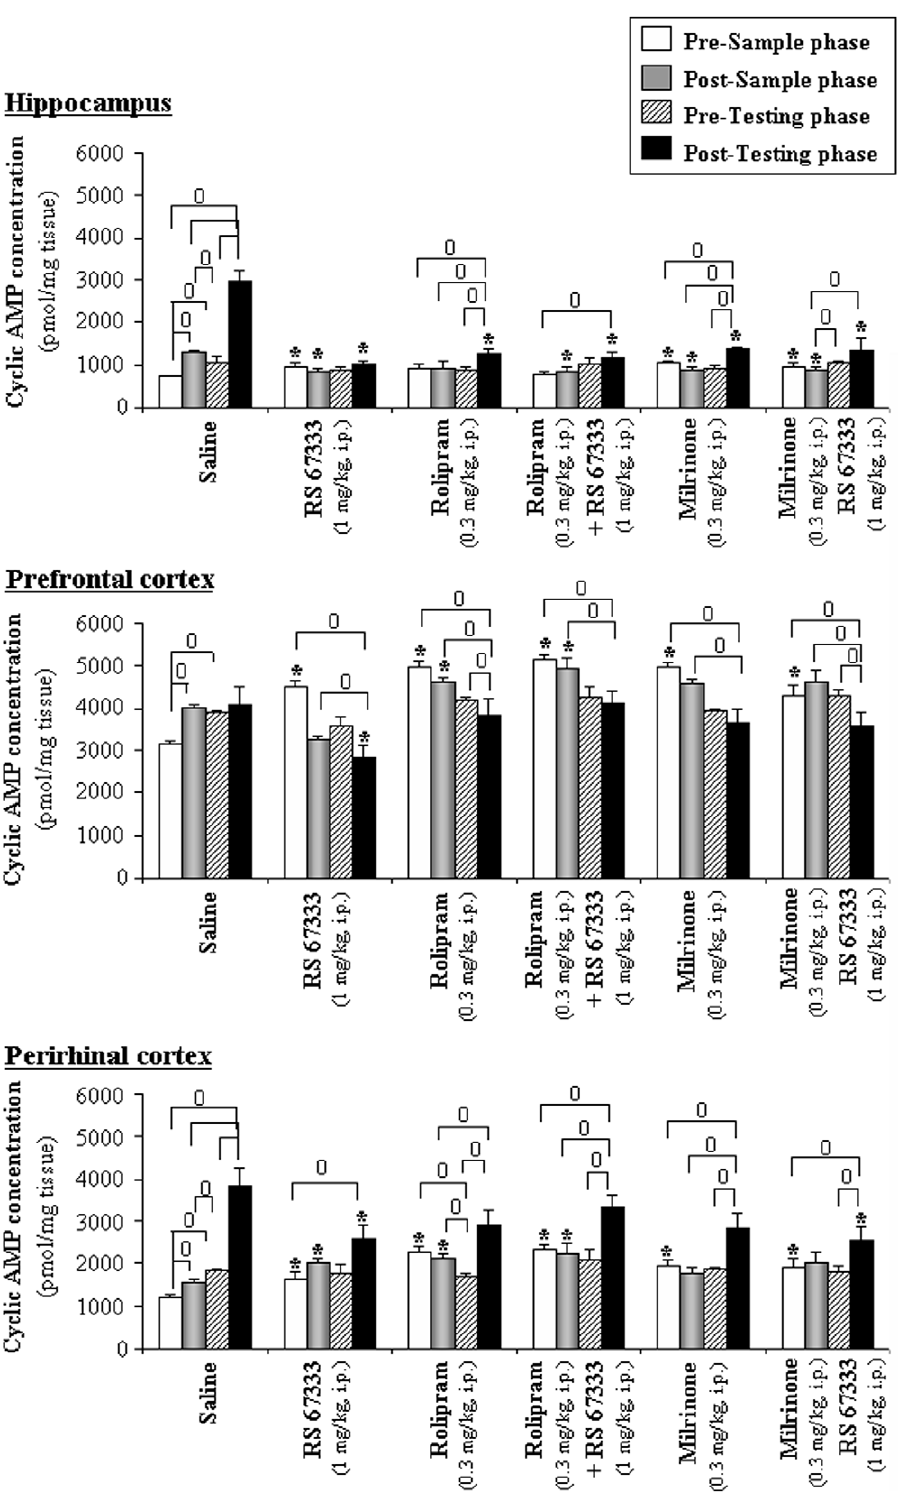
Figure 6. Rolipram and/or RS 67333 induce a biphasic modulation of cAMP concentrations in the hippocampus, prefrontal and perirhinal cortices of rats performing an object recognition task with a 4-h delay. Rats were injected with the inhibitor of PDE4 (rolipram, 0.3 mg/kg, i.p.) and then with saline or the 5-HT4 receptor agonist (RS 67333, 1 mg/kg, i.p.), respectively 45 minutes and 30 minutes before to the sample phase of the object recognition task. Rats were euthanized before or after the sample phase, or before or after the testing phase. Cyclic AMP was extracted from the hippocampus, prefrontal and perirhinal cortices and then assayed. Cyclic AMP was expressed as pmolcAMP/mg of weight tissue. Results were means 6 SEM of three independent extractions performed in duplicate. (0) indicated significant differences in comparison with other steps of the paradigm in each brain sub-region, Mann-Whitney test, P , 0.05. (*) indicated a significant difference in comparison with saline treatment in each brain sub-region. (0,*, P , 0.05).